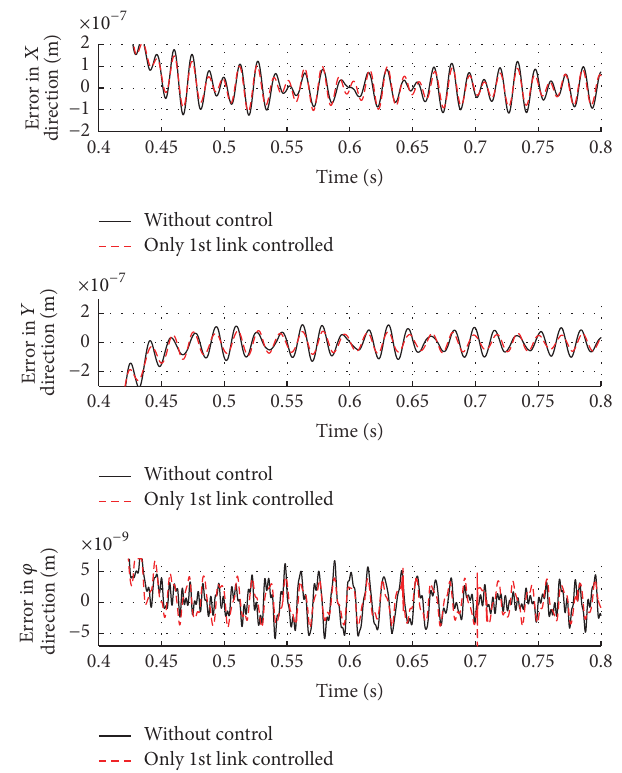
Figure 8: The positioning error of the rigid motion under the second case.